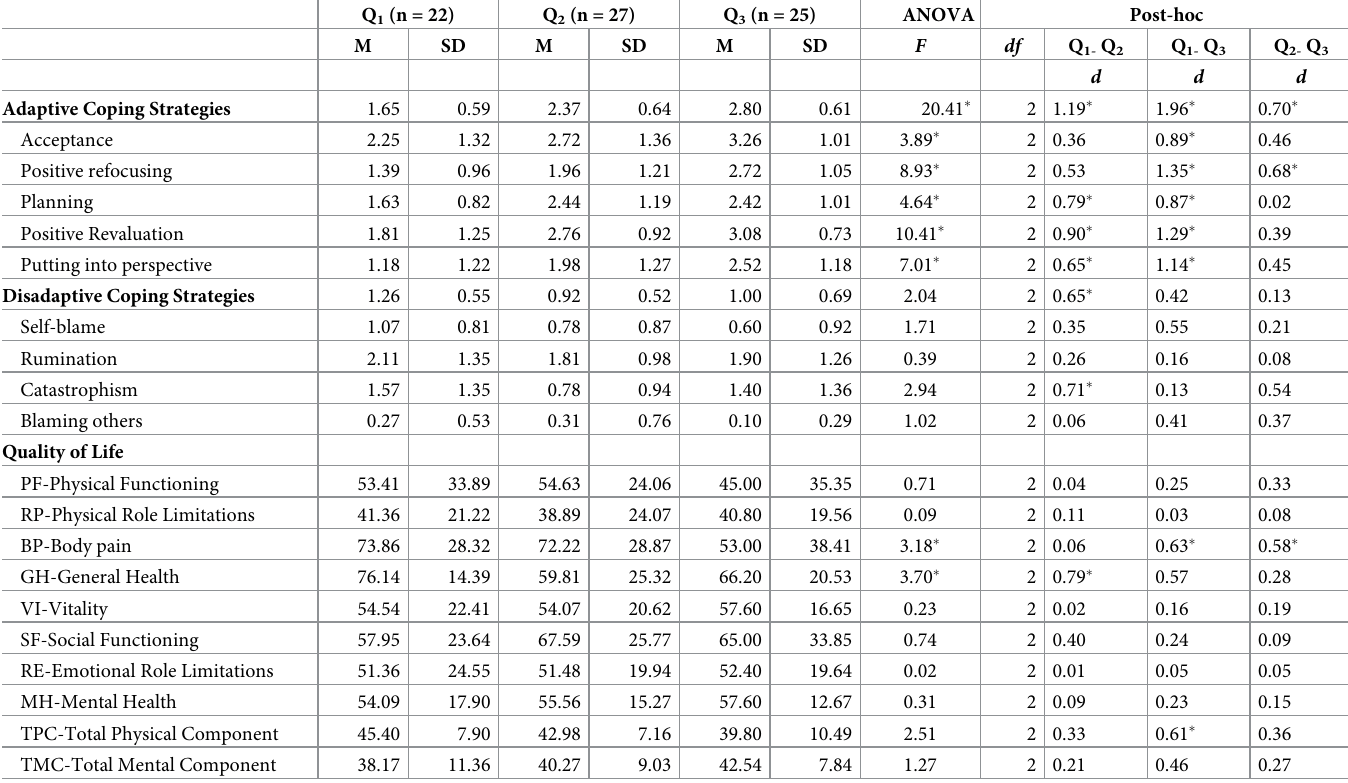
Table 3. Effect sizes for resilience groups with coping strategies and quality of